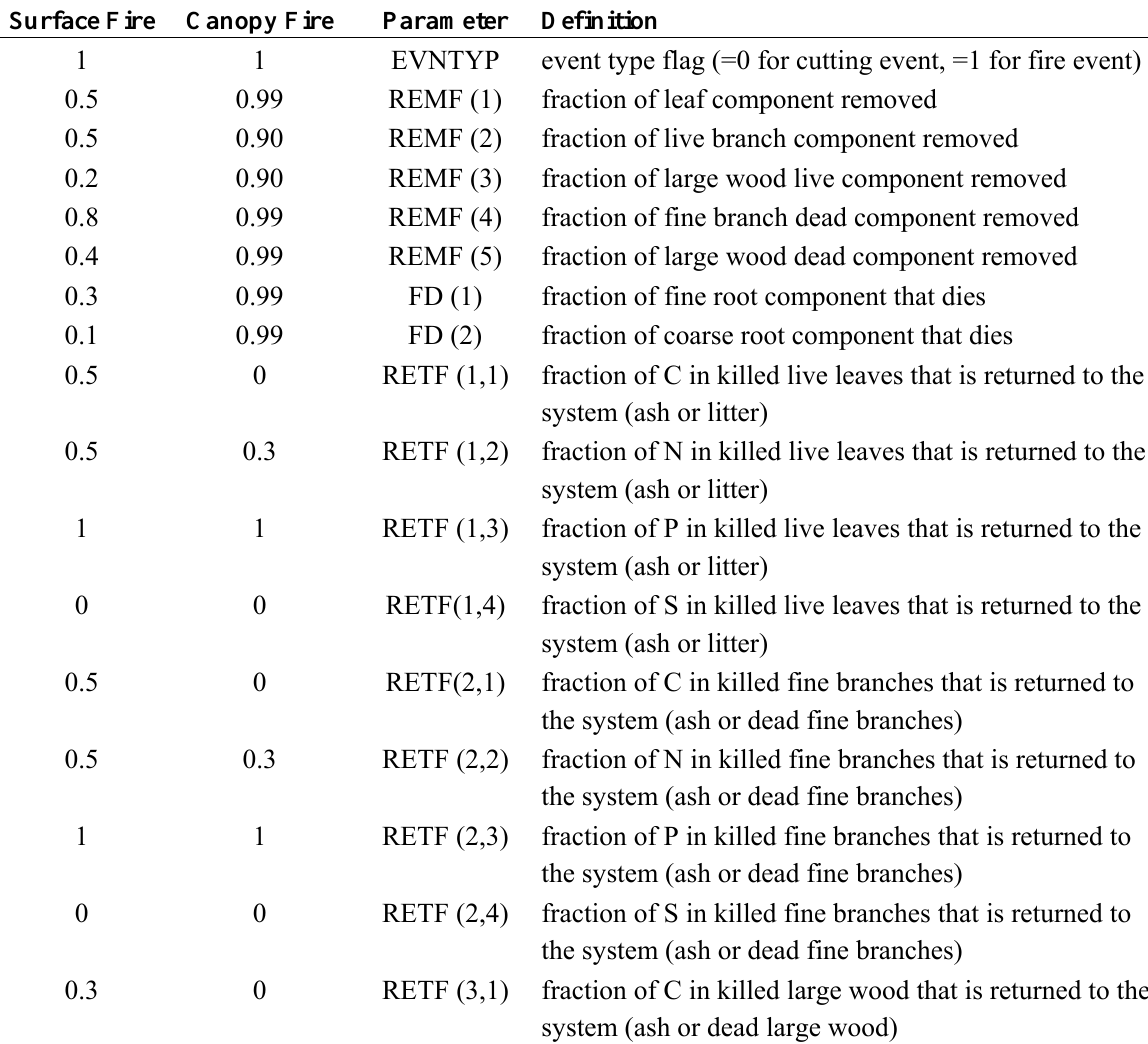
Table 4. A description of DAYCENT input parameters for tree removal (TREM.100) events for two fire severity scenarios: surface (low severity) or canopy (high severity)